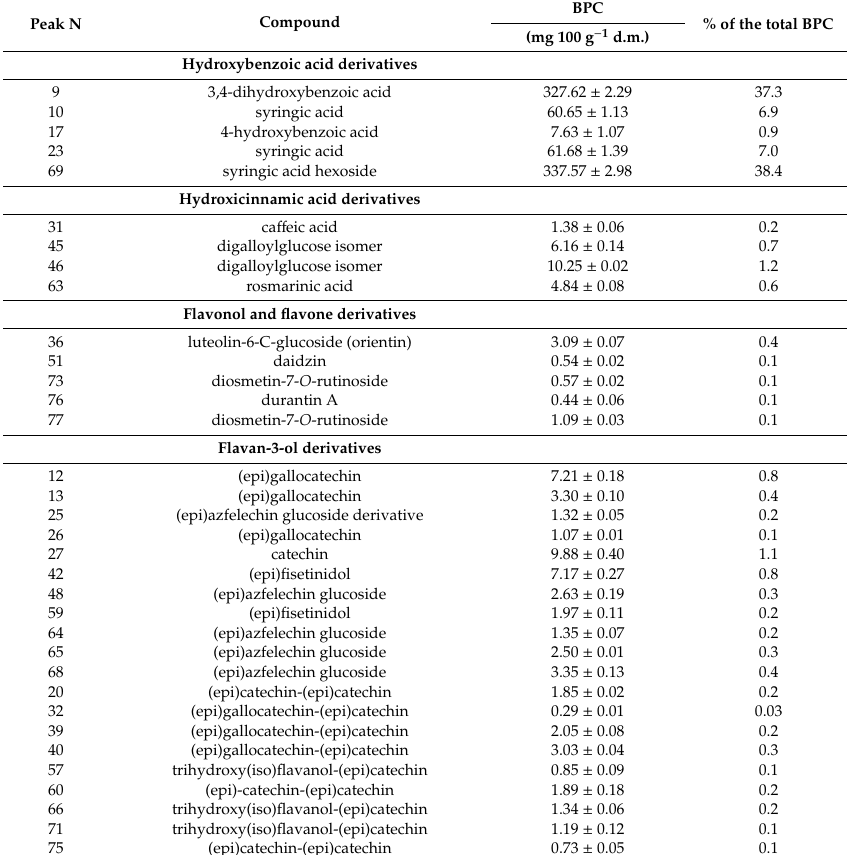
Table 4. Quantification of bound phenolic compounds (BPC) of banana passion fruit pulp (mg 100 g − 1